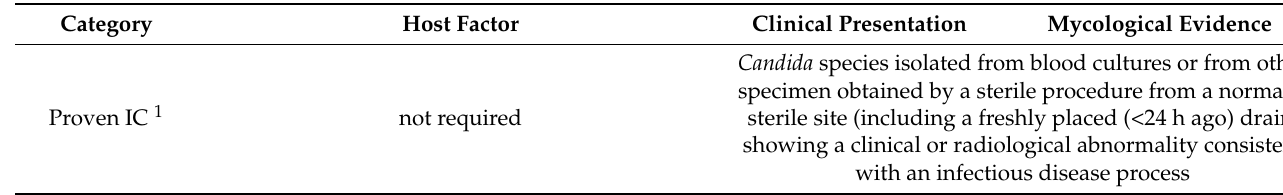
Table A1. Diagnostic criteria for invasive candidiasis used in this